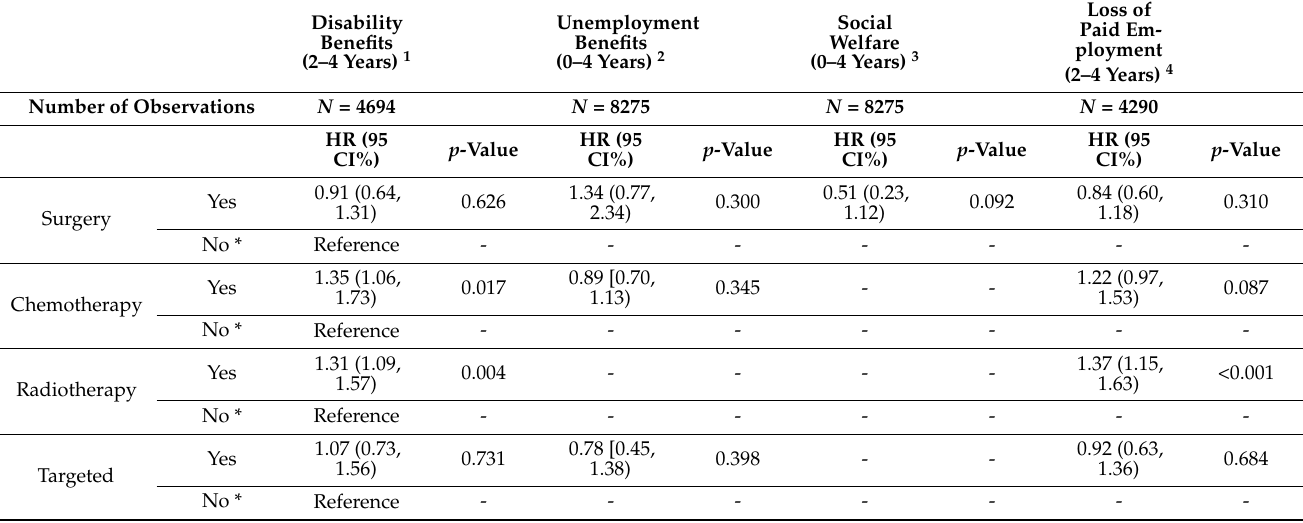
Table 4. Hazard ratios of work-related outcomes in multivariate model in the cancer survivor cohort having paid